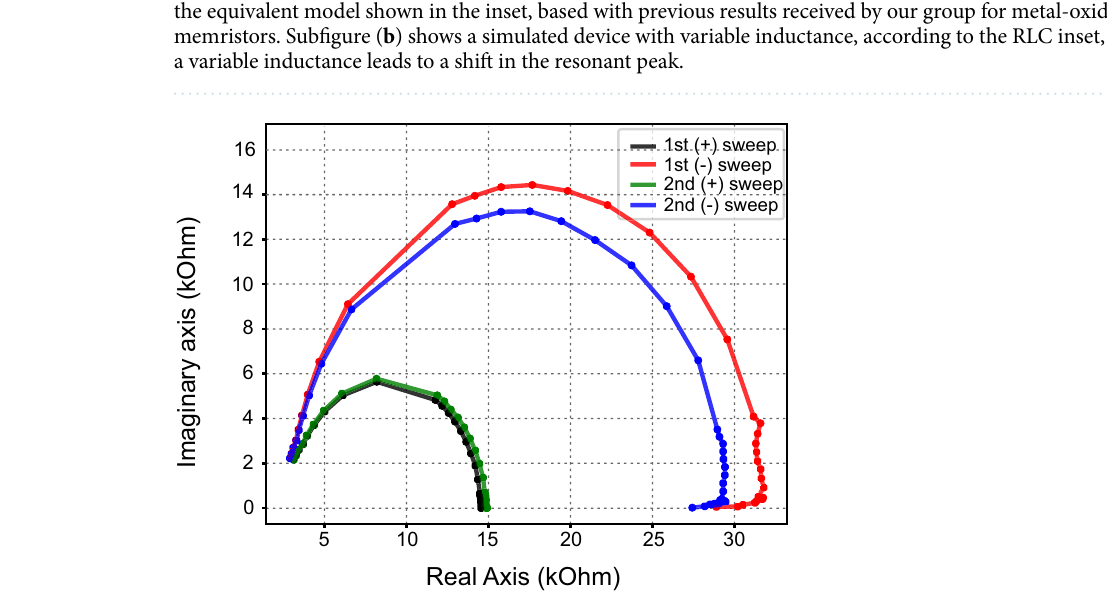
Figure 7. Experimental data measured from a device of TiN/TiO 2 /Pt morphology presents a behavior known as low frequency inductive hook, which appears consistently when a device is switched in higher voltages (− 3 V), only on one polarity, which implies an electrode controlled